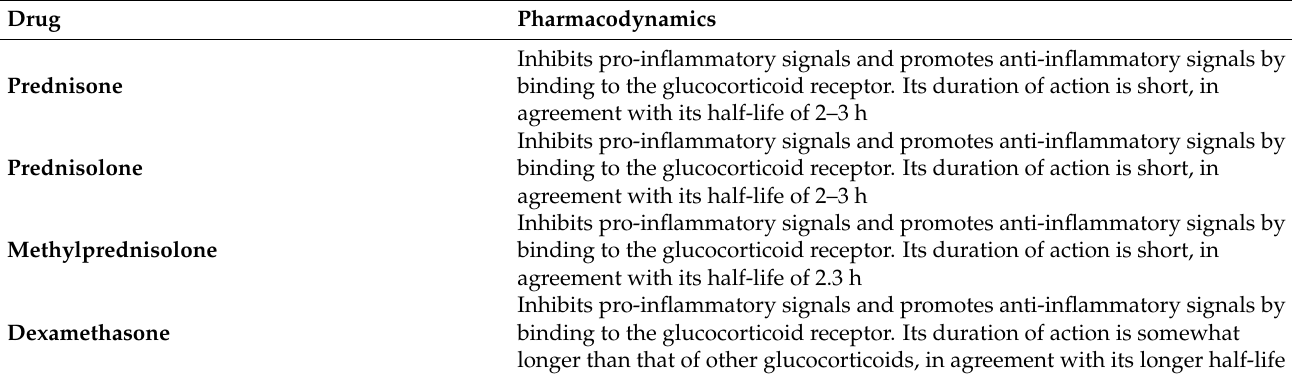
Table 2. Pharmacodynamics of the current first- and second-line drugs indicated to treat ITP